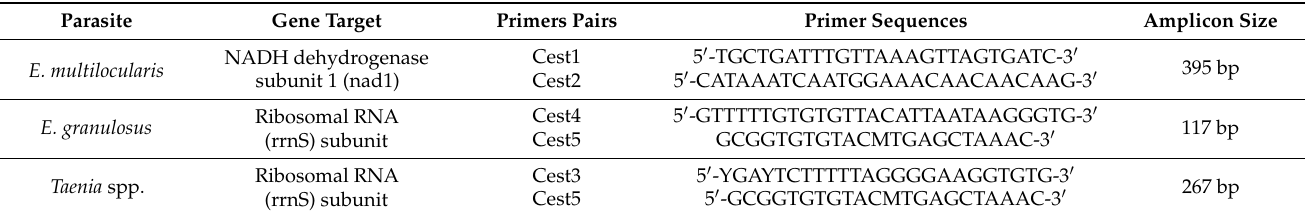
Table 2. Primers used in this study for amplification of gene sequences specific for E. granulosus , E. multilocularis and Taenia